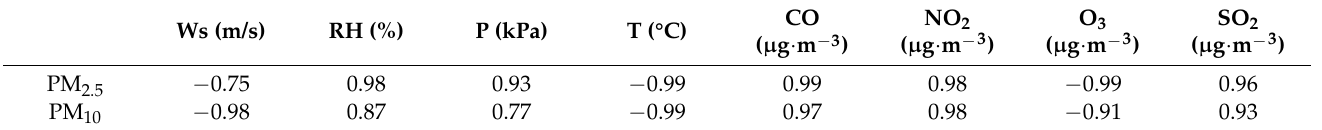
Table 1. Correlation coefficient of PM with meteorological parameters and gas-phase species.